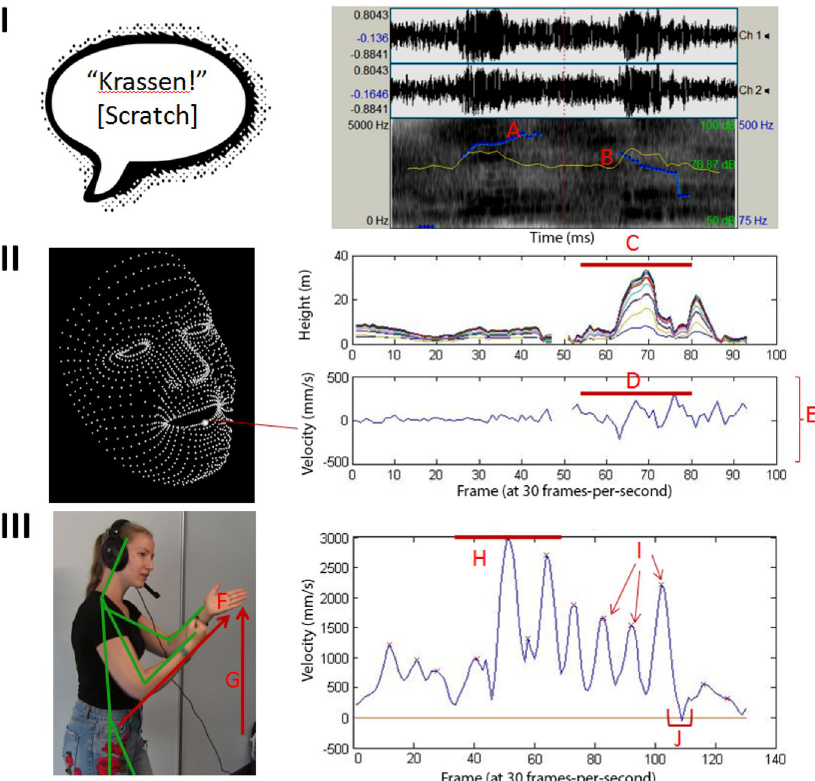
Figure 5. Graphical overview of all communicative features calculated. Panel ( I ) depicts the speech acoustics, with upper right plot (taken from PRAAT) showing the speech waveform together with the intensity and pitch envelopes. Panel ( II ) depicts the face kinematics. The tracked points of the face are displayed on the left, with emphasis on the middle lower lip point that was used for the peak velocity calculation. The right plots of panel ( II ) show the mouth opening and lip movement through time. Panel ( III ) depicts the gesture kinematics. The graphic on the left is a still frame from the same communicative utterance from which the kinematic plots are derived, with an overlay of the Kinect tracking lines. The right bottom plot shows the velocity profile of the right hand. ( A ) F0 is given as the blue line. ( B ) Speech intensity is represented by the yellow line. ( C ) Mouth opening is the highest value within one attempt by any two pair of points. ( D ) Peak lip velocity was the highest velocity achieved by the lower lip. ( E ) The overall amount of movement of the lower lip, taken as the average per second. ( F ) Maximum distance of the hand from its starting point. ( G ) Vertical amplitude of the hands. ( H ) Peak velocity of the hand. ( I ) Number of submovements, visible here as individual peaks. ( J ) Holdtime, seen here as the amount of time spent below the velocity